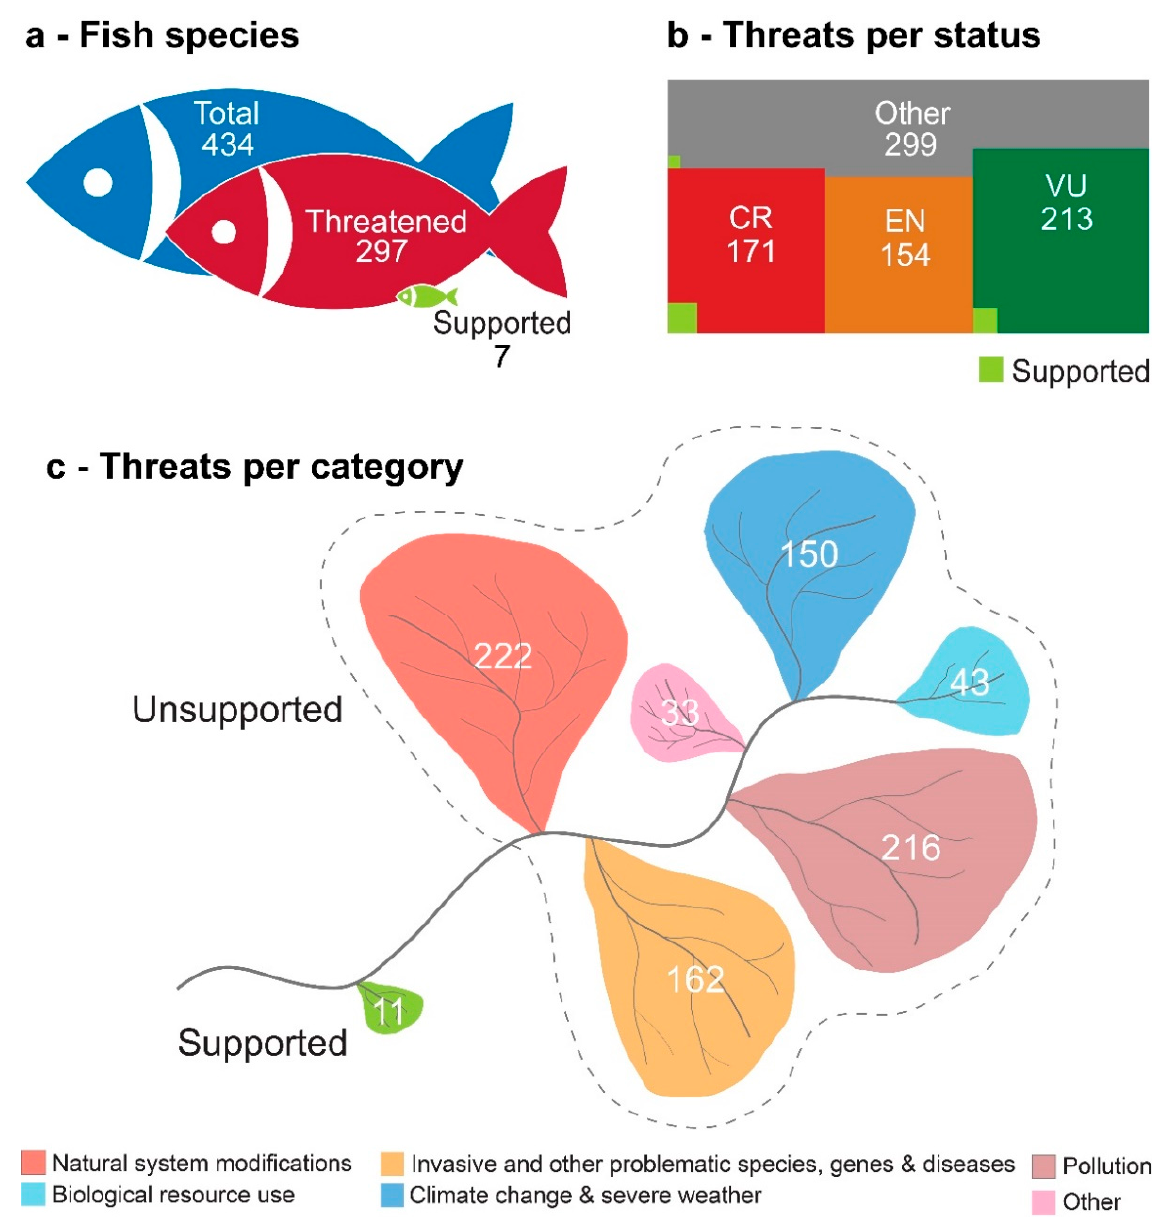
Figure 1. Isotype pictograms of ( a ) the number of fish and lamprey species (total, threatened and at least one threat supported by valid references—the literature is considered valid after assessing the information present in the document in relation to the threat referenced by it); ( b ) the number of threats attributed to each International Union for Conservation of Nature Red List species assessment (IUCN) species status (CR—Critically Endangered; EN—Endangered; VU—Vulnerable; Other—Remaining statuses; Supported—Number of threats supported by valid references); and ( c ) the number of threats by threat category according to the IUCN category list (Other—Threats belonging to the remaining IUCN threats categories; Supported—Number of threats supported by valid